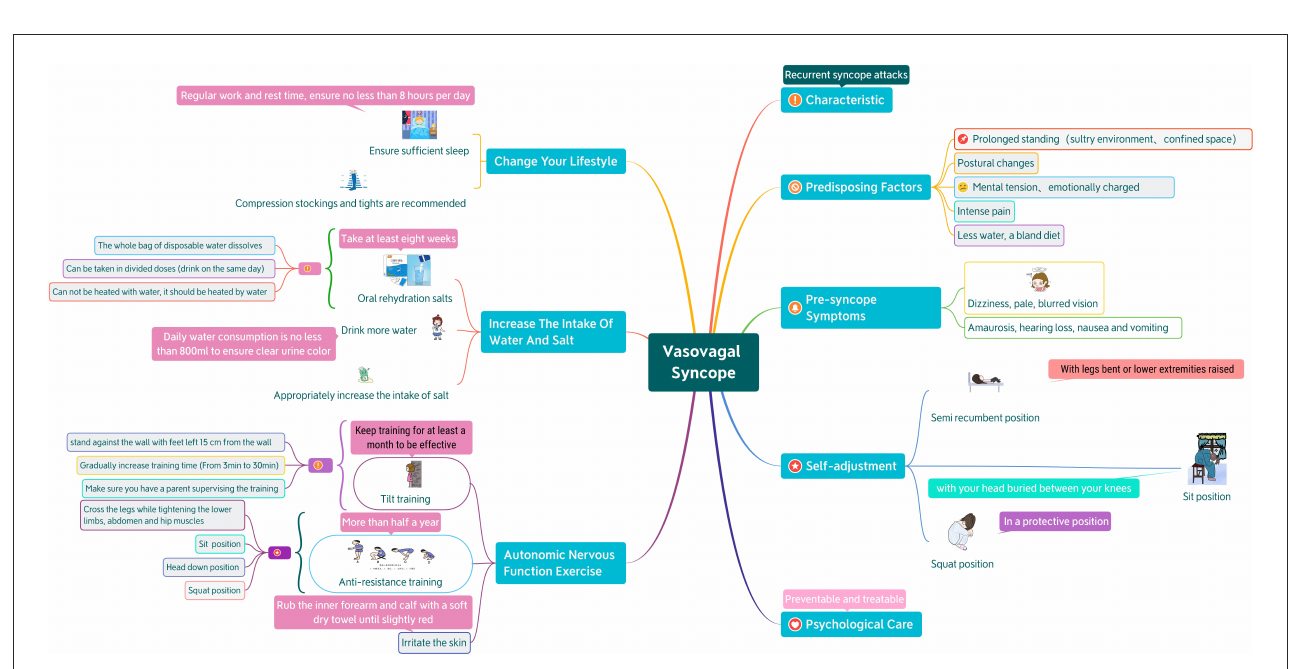
FIGURE2 Mind map of health education for children with vasovagal syncope and their